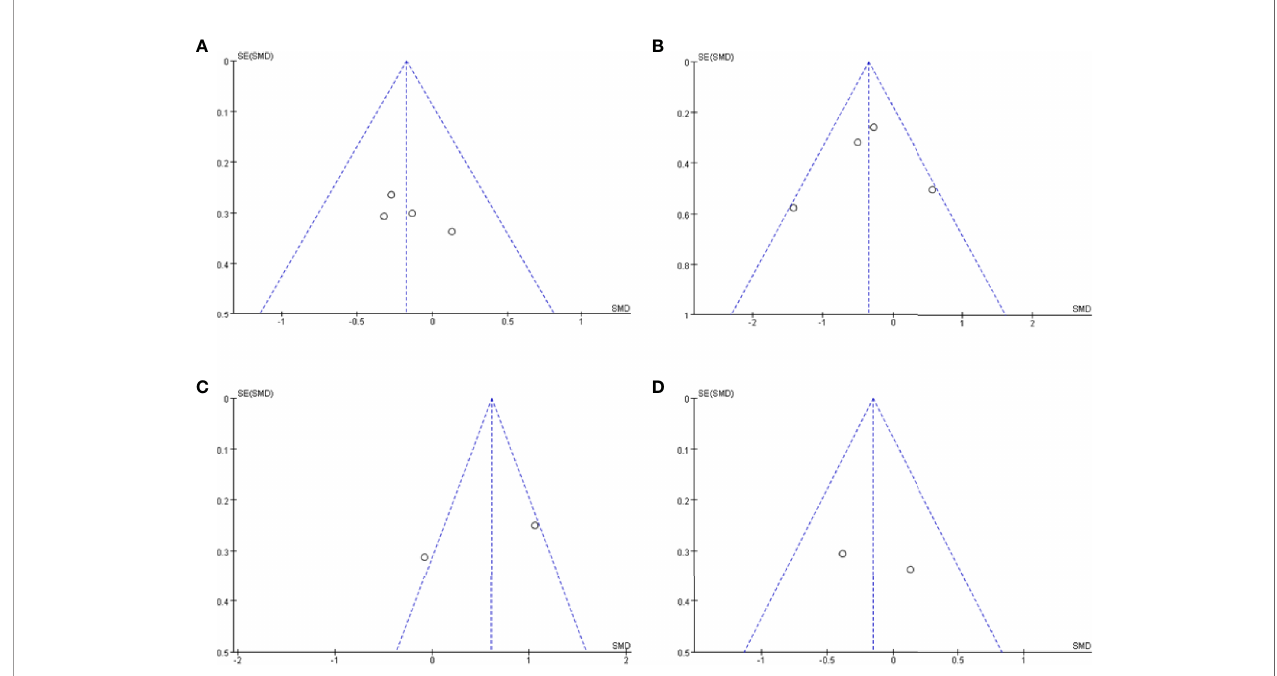
FIGURE 4 | Funnel plot of CSF orexin-A levels in LBD compared with NCs/other diseases. (A) Funnel plot of CSF orexin-A levels in LBD compared with NC. (B) Funnel plot of CSF orexin-A levels in LBD compared with AD. (C) Funnel plot of CSF orexin-A levels in LBD compared with FTLD. (D) Funnel plot of CSF orexin-A levels in LBD with EDS compared with NCs. CSF, cerebrospinal fl uid; LBD, Lewy body disease; NCs, normal controls; AD, Alzheimer ’ s disease; FTLD, frontotemporal lobar degeneration; EDS, excessive daytime sleepiness; SMD, standardized mean